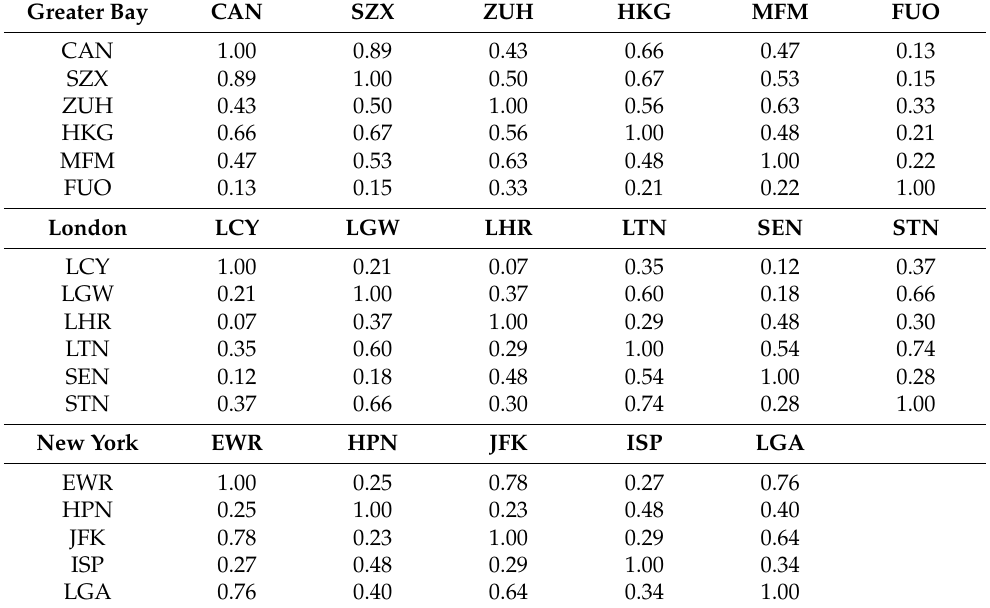
Table A5. Homogenization result of BS.